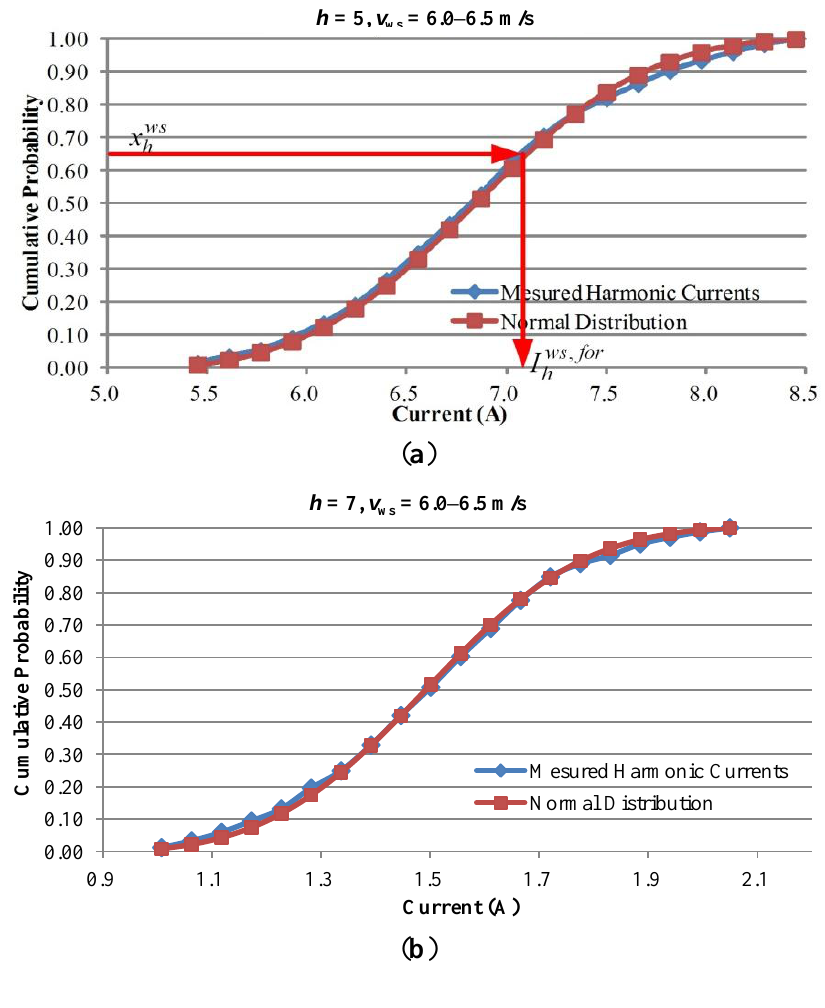
Figure 7. Cumulative probabilities of the 5/7/11th order harmonic currents. ( a ) 5th order harmonic current; ( b ) 7th order harmonic current; ( c ) 11th order harmonic